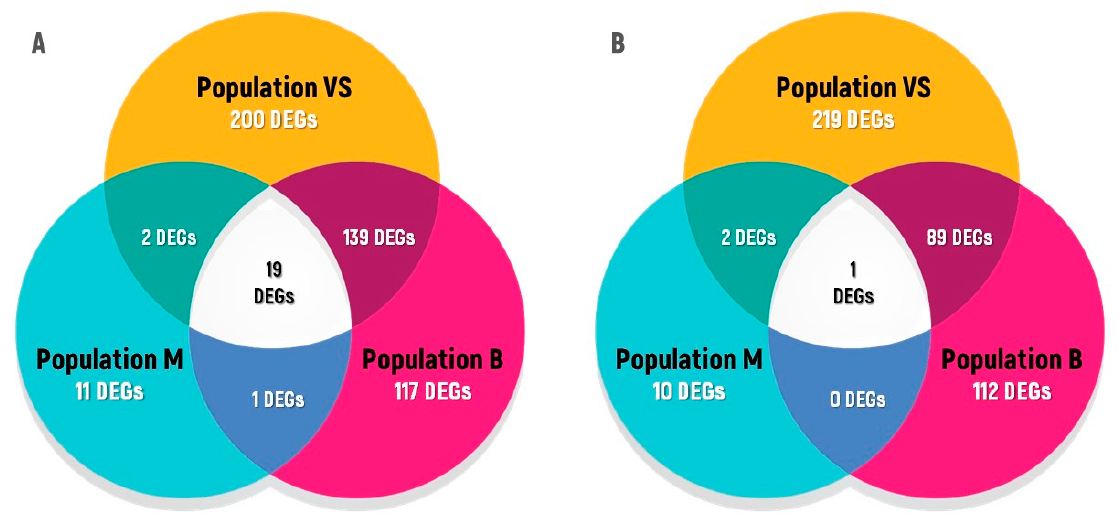
Figure 10. Unique and common responses to acute irradiation of seeds (150 Gy) for seedlings of A. thaliana from the CEZ. ( A )—upregulated genes; ( B )—downregulated genes. The graph was created using the Microsoft PowerPoint 2019 (Microsoft Corporation, Albuquerque, NM, USA).